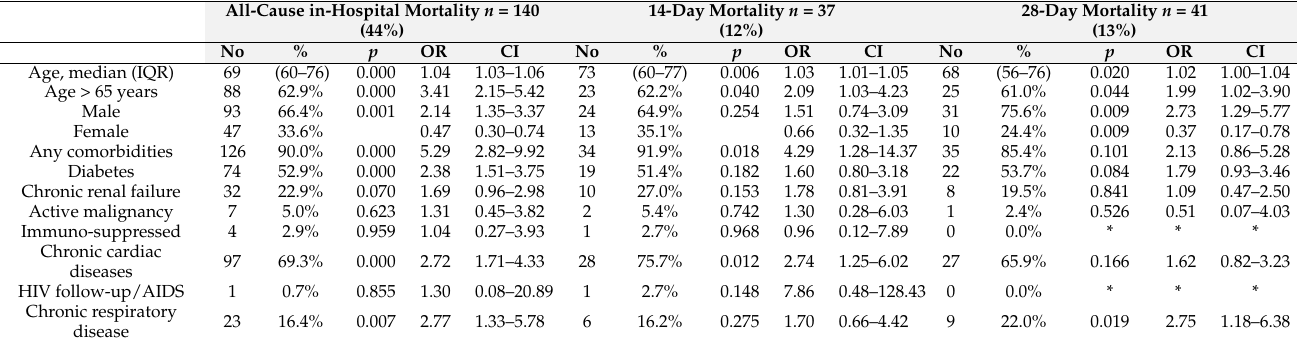
Table 1. Patient-related variables versus mortality rates (Binary logistic